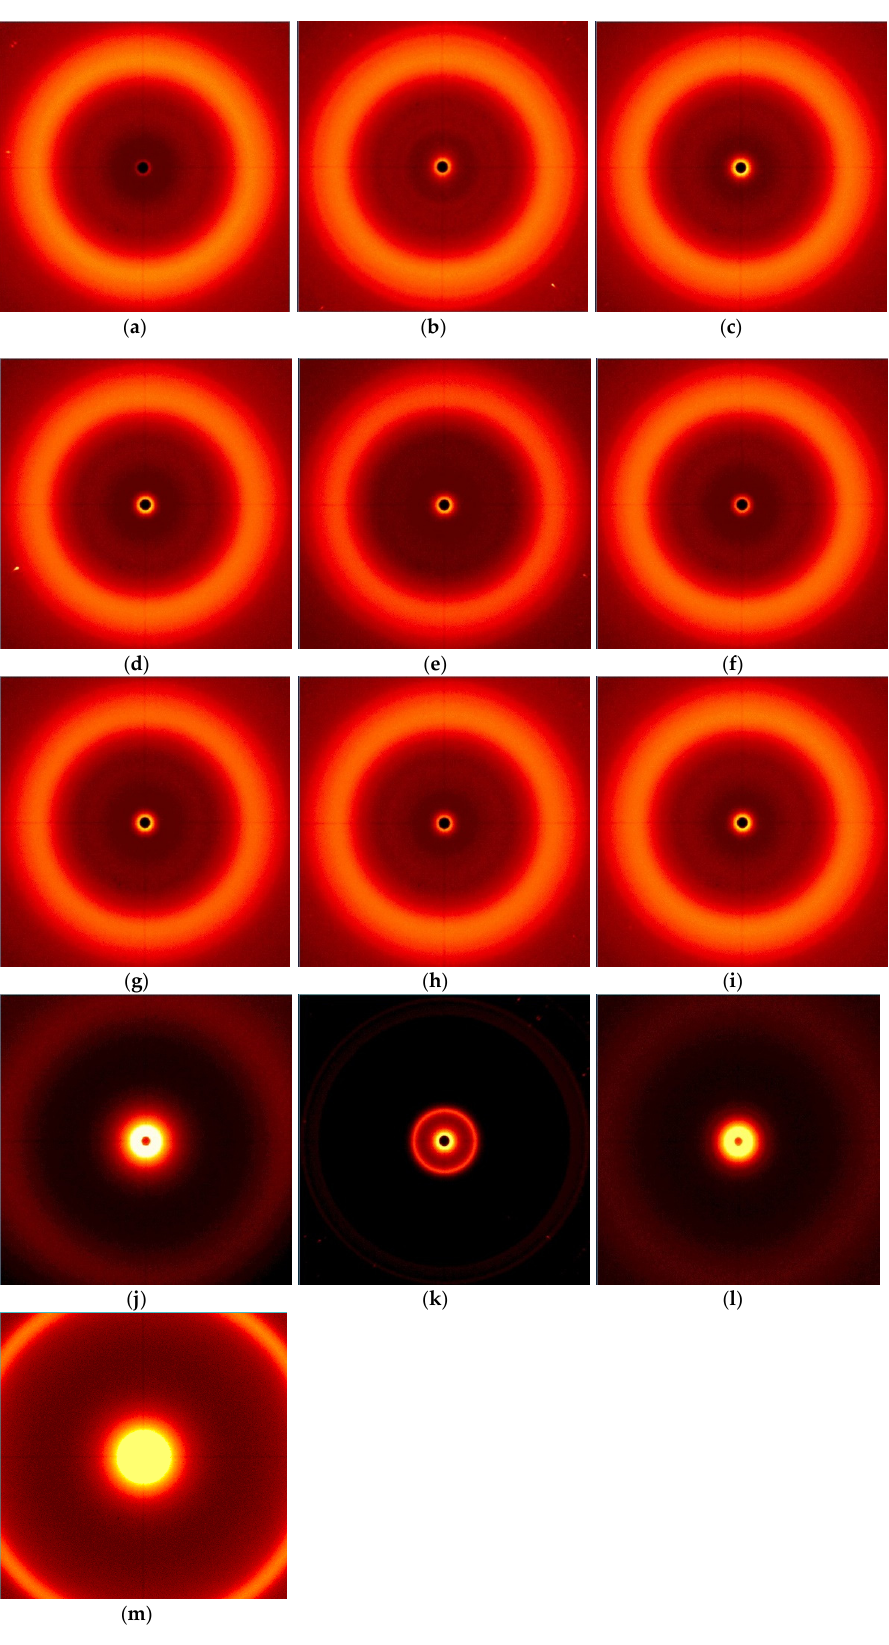
Figure 13. Two-dimensional WAXS images: ( a ) PC; ( b ) PC/3%S; ( c ) PC/3%B; ( d ) PC/3%L; ( e ) PC/1.5%L/1.5%B; ( f ) PC/0.5%CN; ( g ) PC/0.5%CN/1.5%S; ( h ) PC/0.5%CN/1.5%B; ( i ) PC/0.5%CN/1.5%L; ( j ) S; ( k ) B; ( l ) L; ( m ) CN.